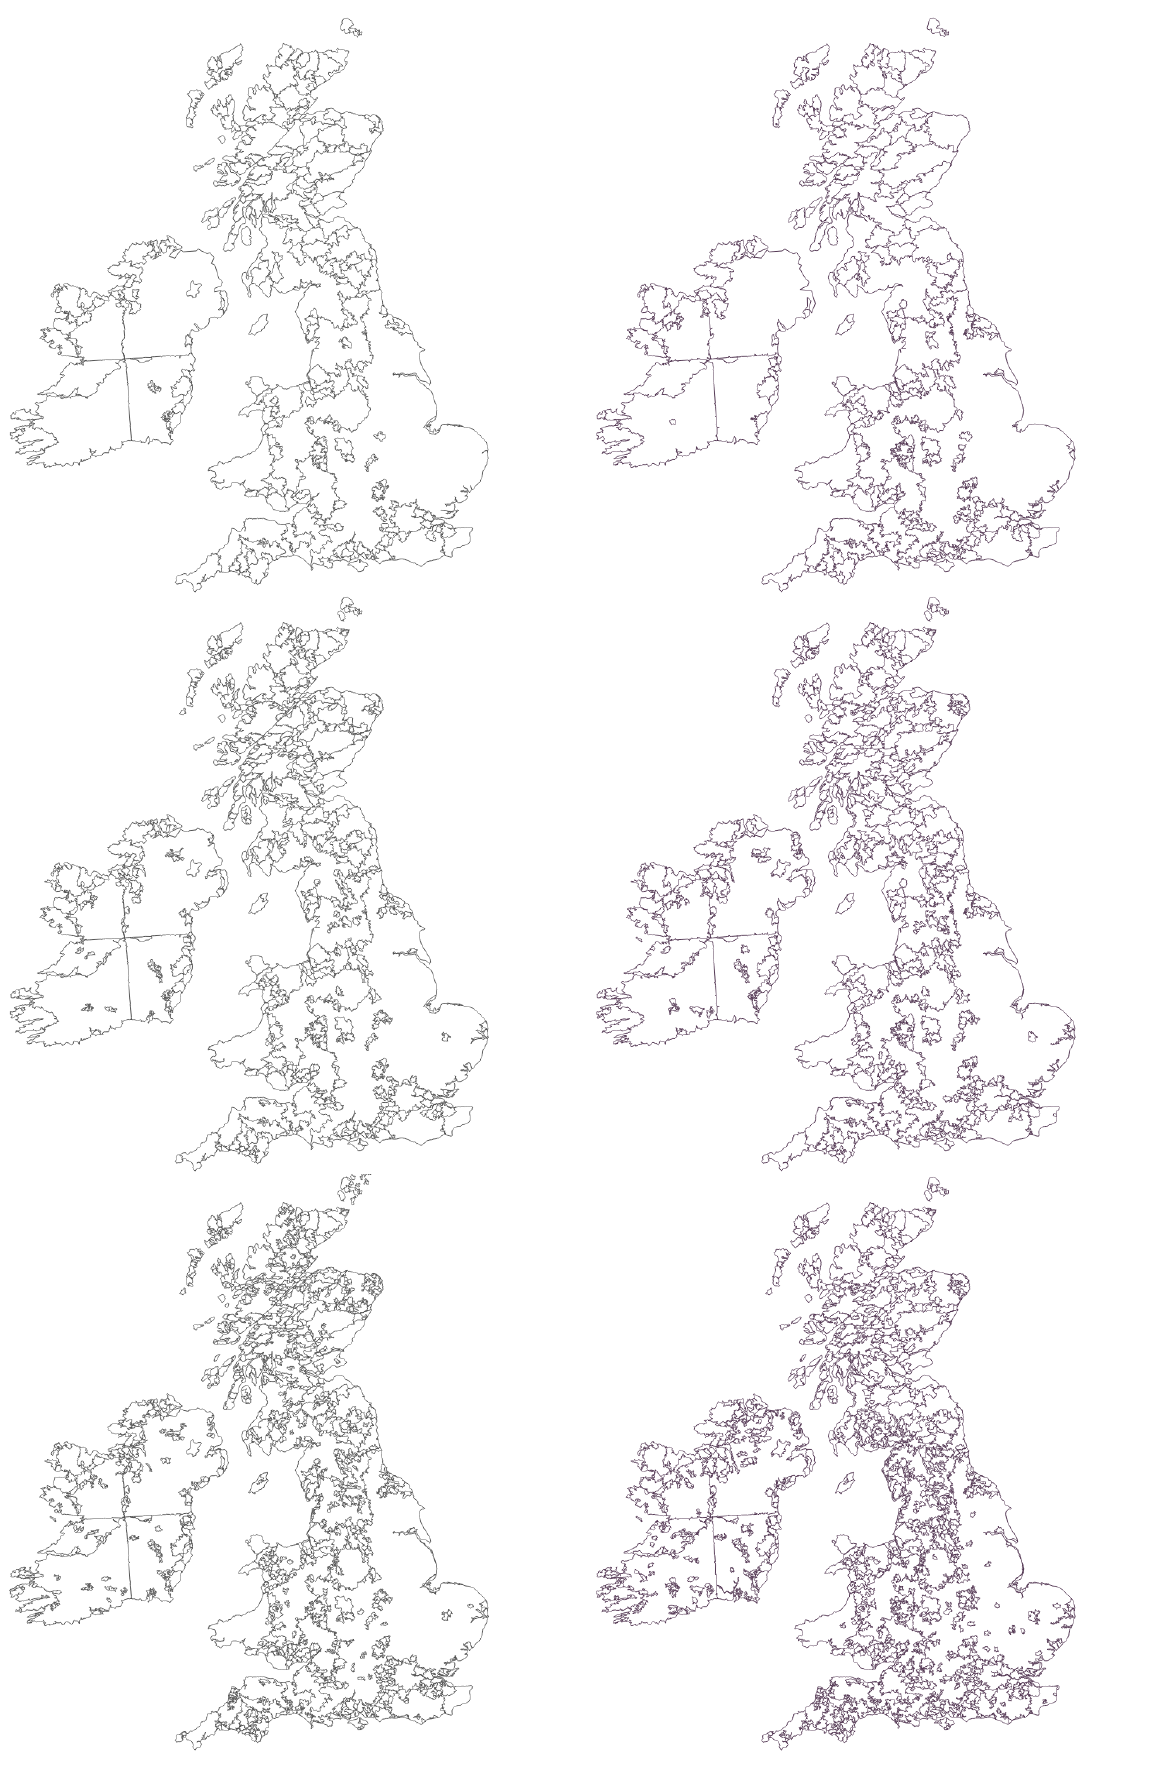
Figure 8: The visual comparison of a sequential run (in left column) and run in parallel (in right). The rows display different amount of feature 250, 500 and 1000 from top to